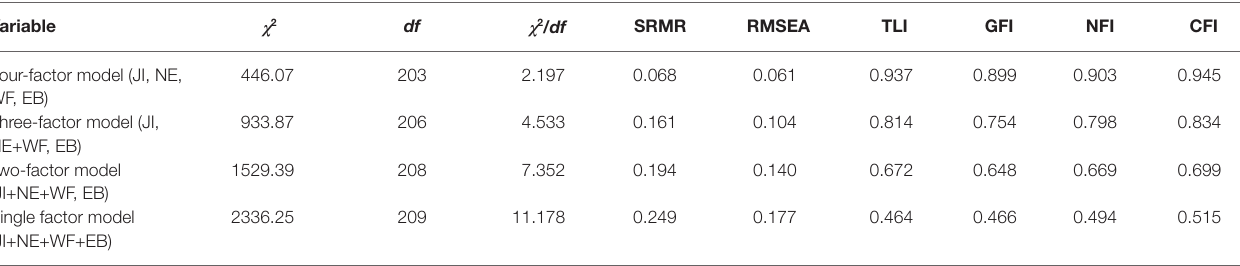
TABLE 1 | Confirmatory factor